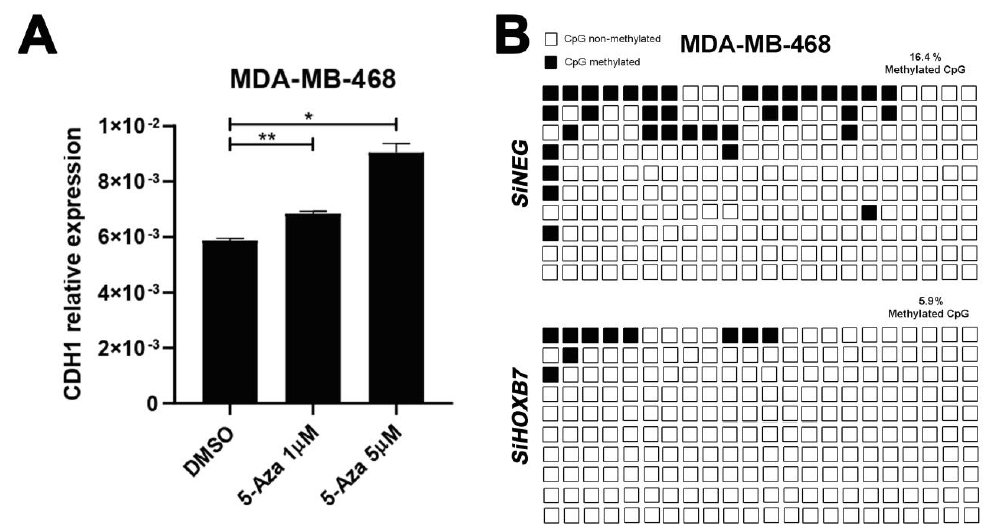
Figure 4. Influence of HOXB7 overexpression in CDH1 regulation in MDA-MB-468 triple-negative Figure 4 breast cancer cells. ( A ) Expression analyses of CDH1 in 5-Aza-2 (cid:48) deoxycytidine treated cells analyzed by RT-qPCR. Three independent biological replicates were used in the statistical analyses, and significant differences were indicated with asterisks based on the analyses using t -test (**, p < 0.05, *, p < 0.001). ( B ) Methylation status of the CDH1 promoter in HOXB7-silenced cells and controls. Bisulfite sequencing analyses revealed lower CDH1 promoter methylation in cells transfected with siHOXB7 than in controls transfected with siNEG. CpGs regions are identified by squares: black squares represent methylated cytosine and white squares represent unmethylated cytosine. Each row represents a single